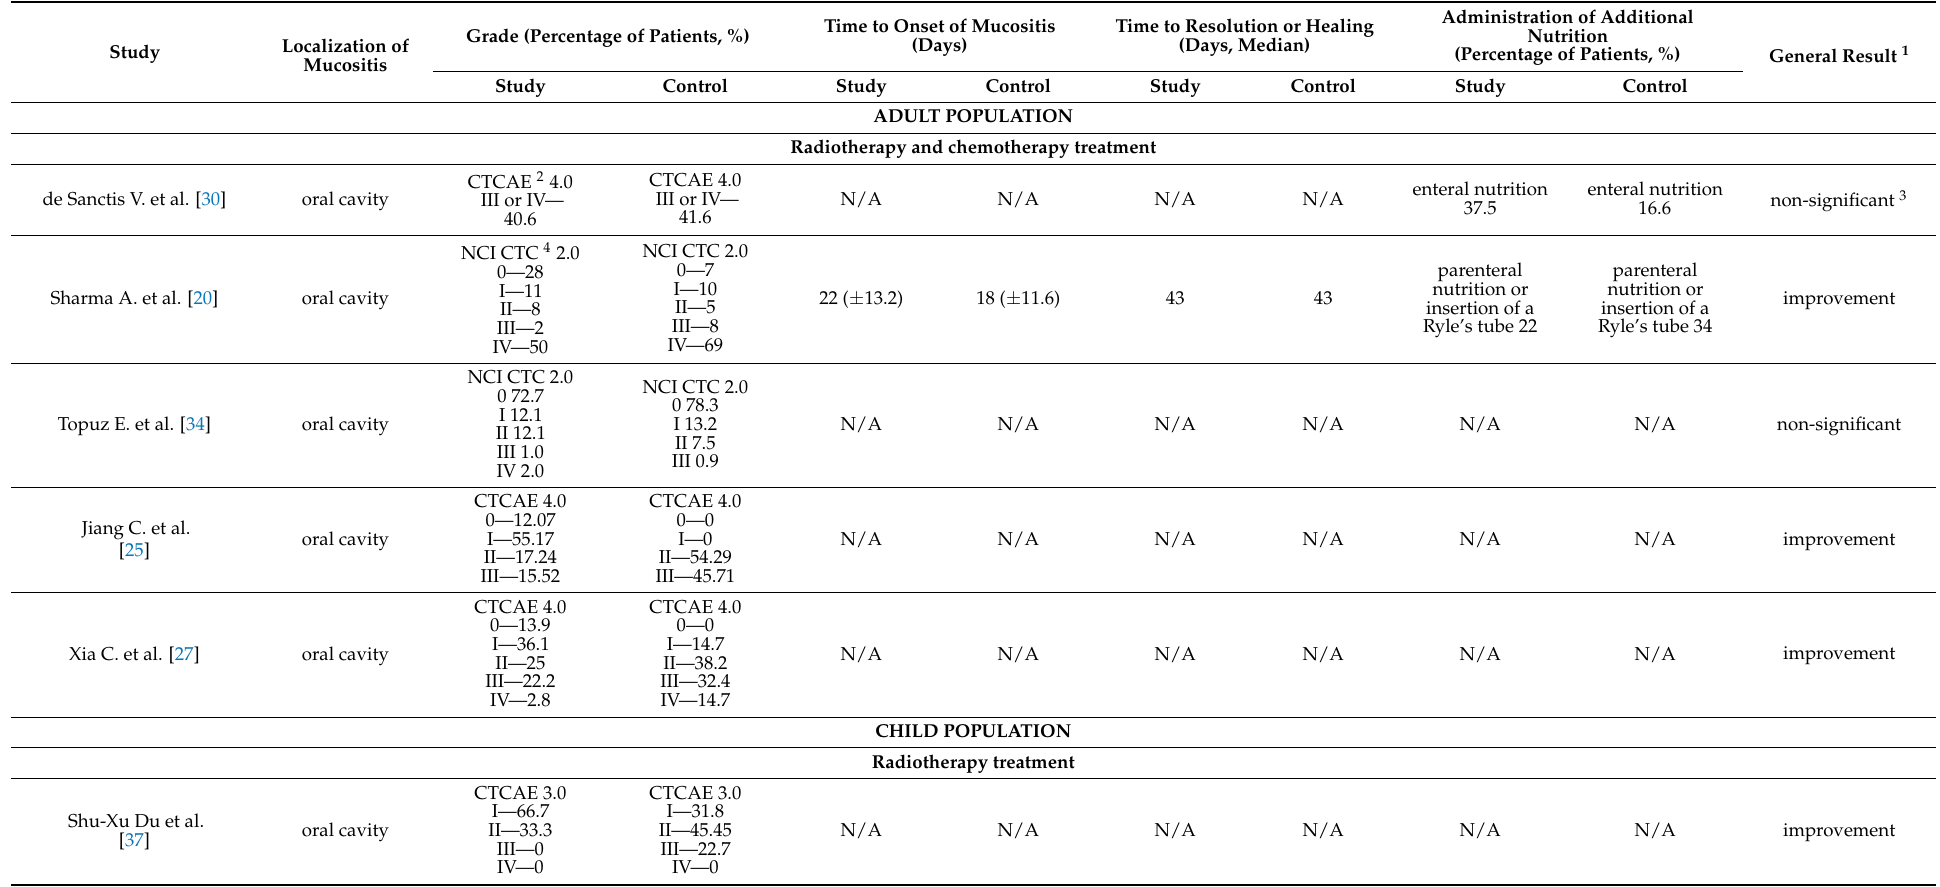
Table 6. The occurrence of mucositis during the probiotic